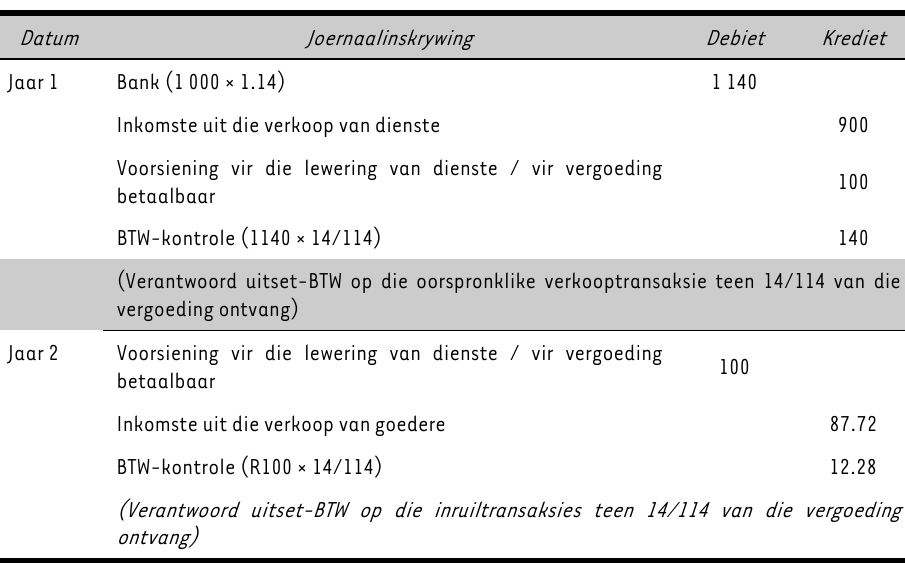
programtransaksie (Verpligting om voordele te lewer rus op die programeienaar of op ‘n programvennoot: Die verbruiker het